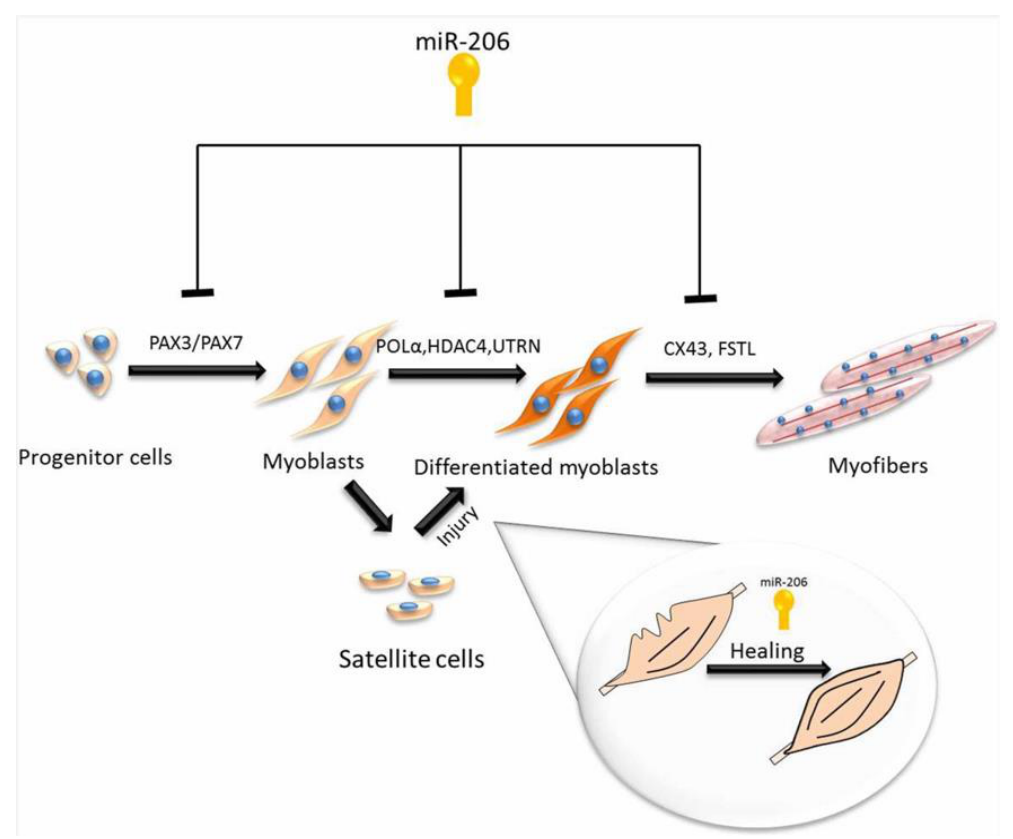
Figure 3. Roles of microRNA-206 in muscle regeneration and development.